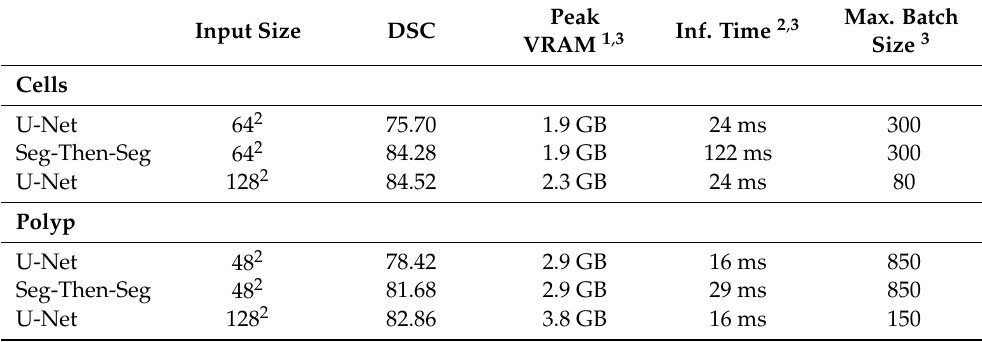
Figure 4. Example outputs from the models at various input sizes. ( a ) Cells dataset. ( b ) Polyp dataset. ( c ) Aorta dataset. Table 4. Performance characteristics of our approach compared to the baseline model with similar mean test Dice Score